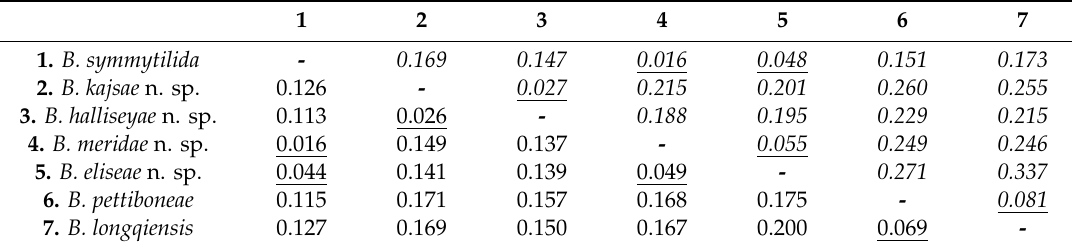
Table 3. Minimum uncorrected interspecific distances (lower diagonal) and minimum HKY + G corrected interspecific distances (upper diagonal, italics) for Branchipolynoe species ITS data. There are no data for B. seepensis or B. tjiasmantoi n. sp. Underlined distances are discussed in the